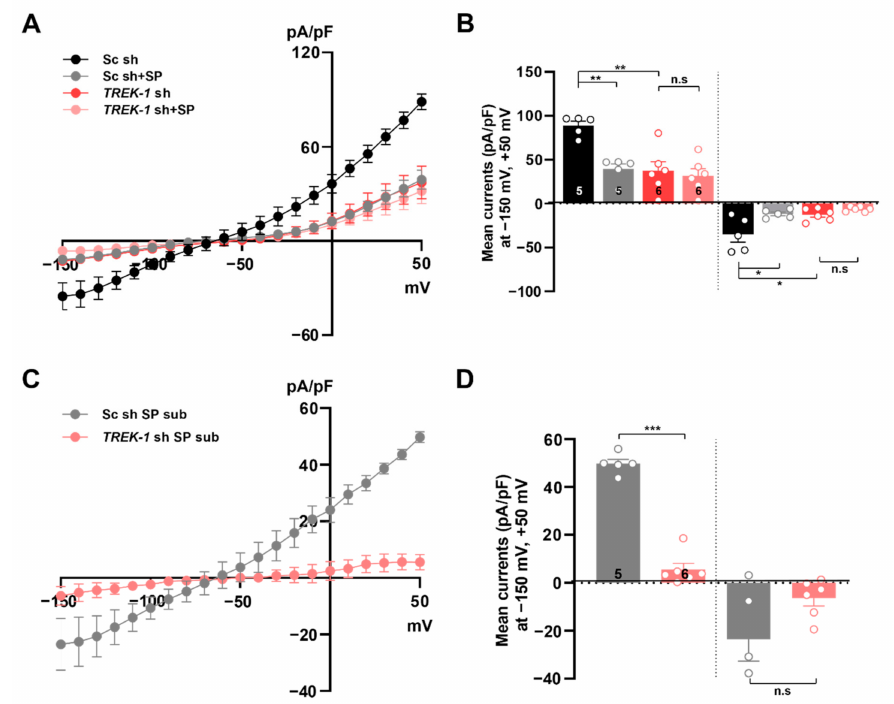
Figure 2. Spadin inhibits TREK-1 mediated current in cultured astrocytes. ( A ) Current densities induced by voltage ramping were measured before and after application of 10 µ M spadin (SP) in astrocytes transfected with scrambled control (Sc) short hairpin-forming interfering RNA (shRNA) (Sc sh) or TREK-1 shRNA. ( B ) Summary bar graph showing averaged currents with or without spadin treatment at + 50 mV and − 150 mV in ( A ). The number on each bar indicates n for each condition. All values are mean ± s.e.m. p -values were obtained with one-way ANOVA followed by Turkey’s post hoc test. n.s: not significant, * p < 0.05 and ** p < 0.01. ( C ) Spadin-sensitive currents (SP sub) were calculated by the di ff erence between currents before and after spadin application in astrocytes in ( A ). ( D ) Bar graph indicates spadin-sensitive currents averaged from results in ( C ) at + 50 mV and − 150 mV. The number on each bar indicates n for each condition. All values are mean ± s.e.m. p -values were obtained with Student’s t -test. n.s: not significant, *** p <